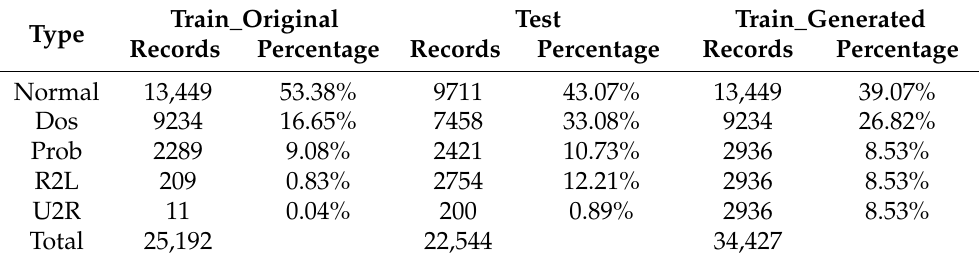
Table 2. The details of the NSL-KDD